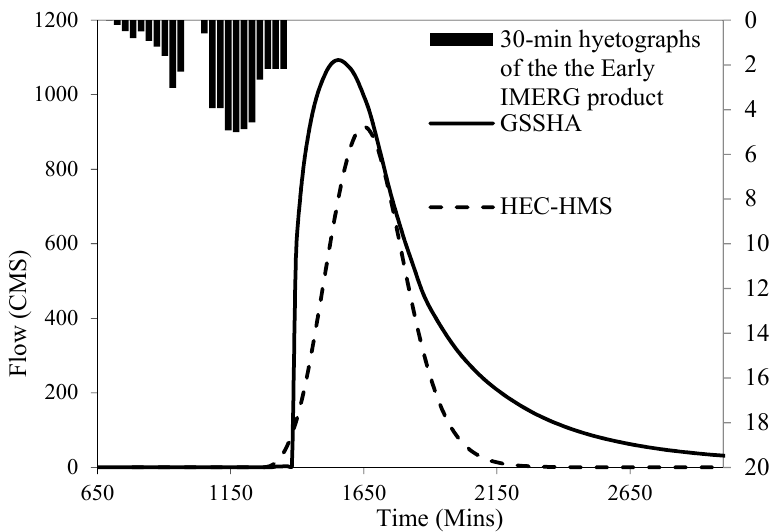
Figure 14. The 13 February 2010 outlet hydrographs simulated by HEC-HMS and GSSHA models at the outlet of the Makkah watershed.